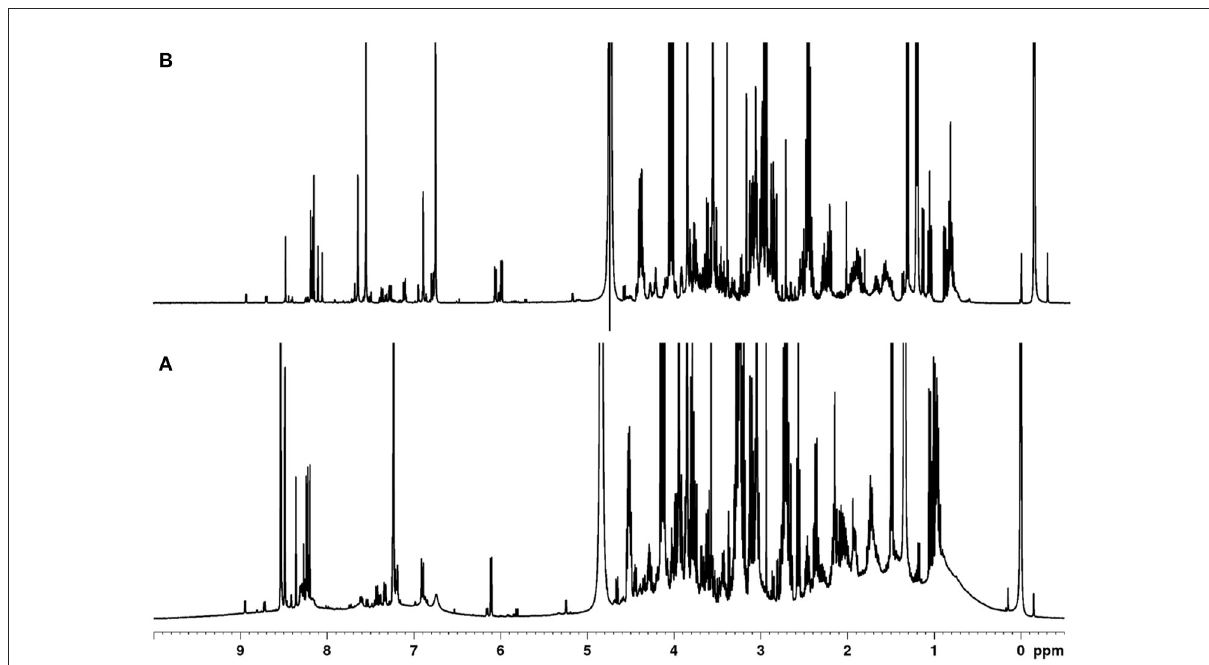
FIGURE1 Comparison of the 400 MHz- 1 H NMR spectra of a polar meat extract without (A) and after protein removal (B)